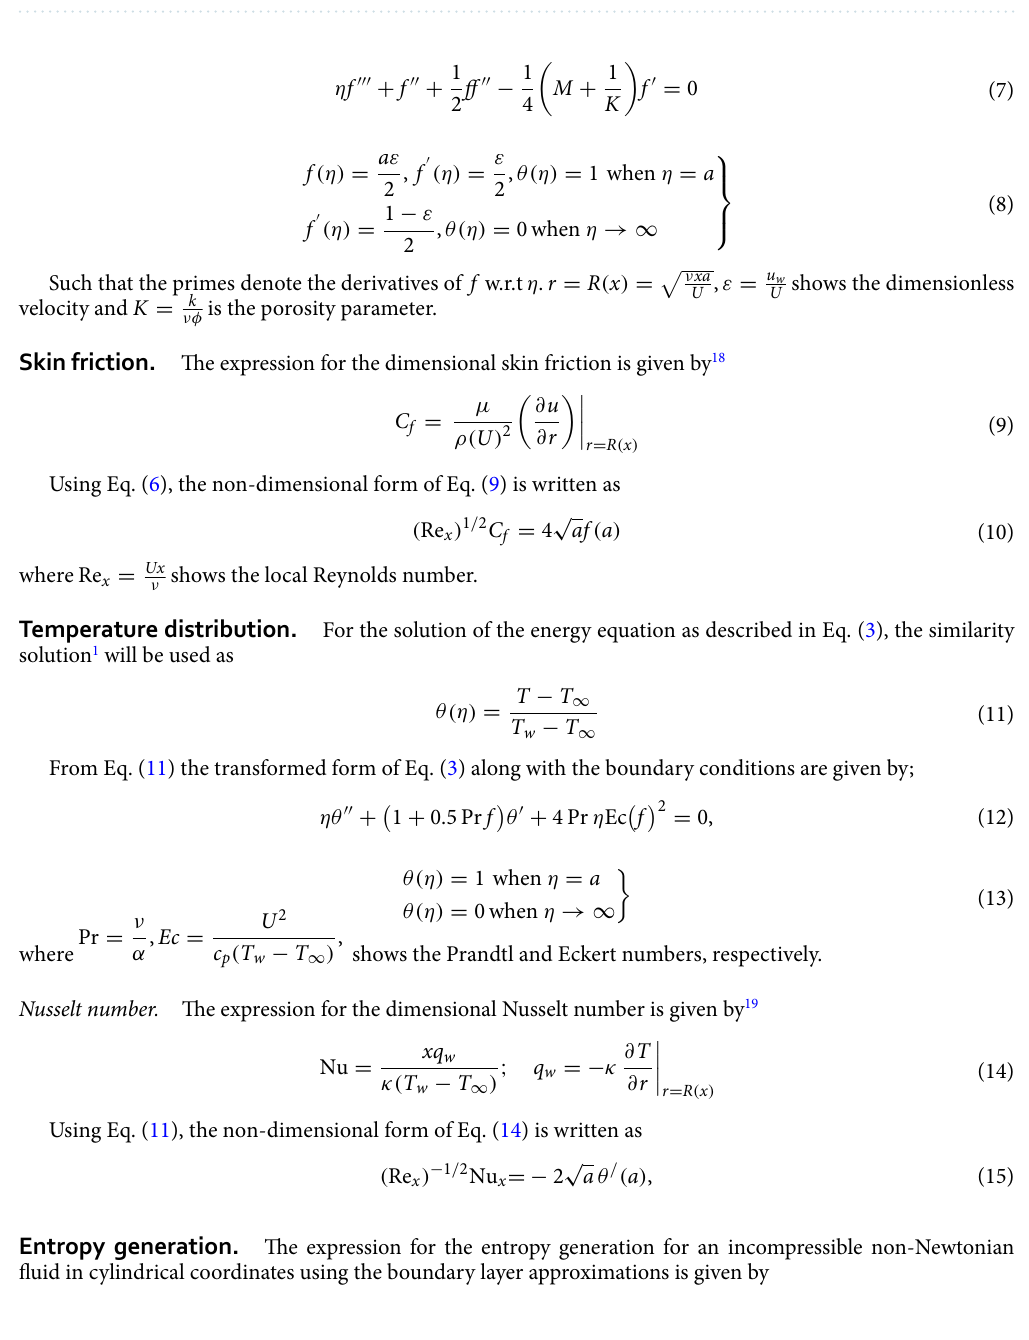
Figure 1. Physical configuration of the